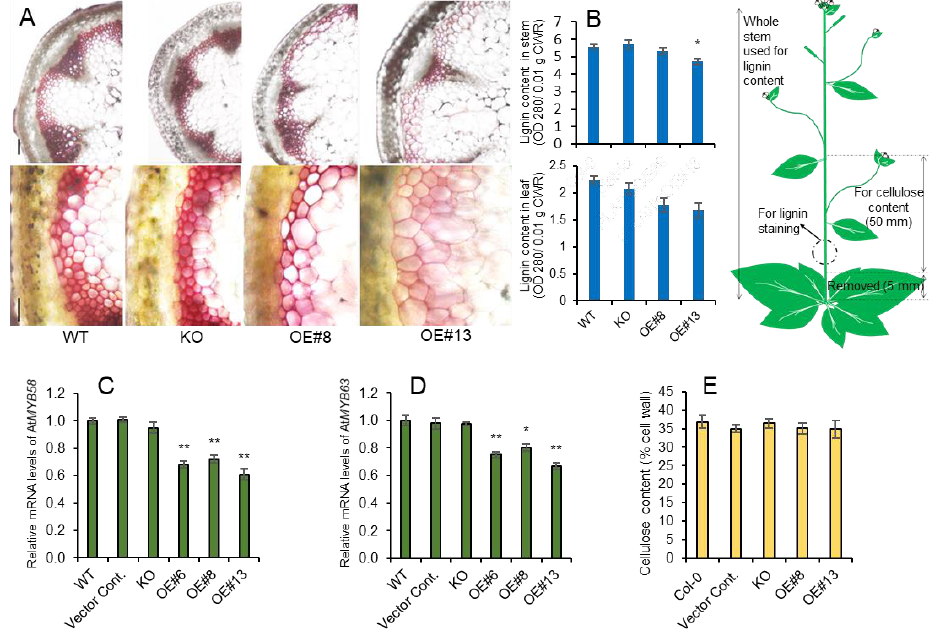
Figure 2. Reduced lignin content in stems of AtpPLAIIIα-OE did not affect cellulose content. ( A ) Histochemical staining of cross sections from 7-week-old stems from WT, KO , and OE lines using Phloroglucinol-HCl. Scale bars = 100 µm. ( B ) Lignin content of 7-week-old stem and leaf assessed by acetylbromide. ( C , D ) Relative gene expression of transcription factors, AtMYB58 and AtMYB63 , involved in lignin biosynthesis was decreased. The Ct value for each gene was normalized to that for β-actin and was calculated relative to a calibrator using the formula 2 -ΔΔCt . ( E ) Cellulose content of 7- week-old stems of WT, KO , and OE lines was not changed; n = 5. Data ( B – D ) represent the mean ± SE of three independent replicates at P < 0 . 05 (*) and P < 0 . 01 (**), respectively.